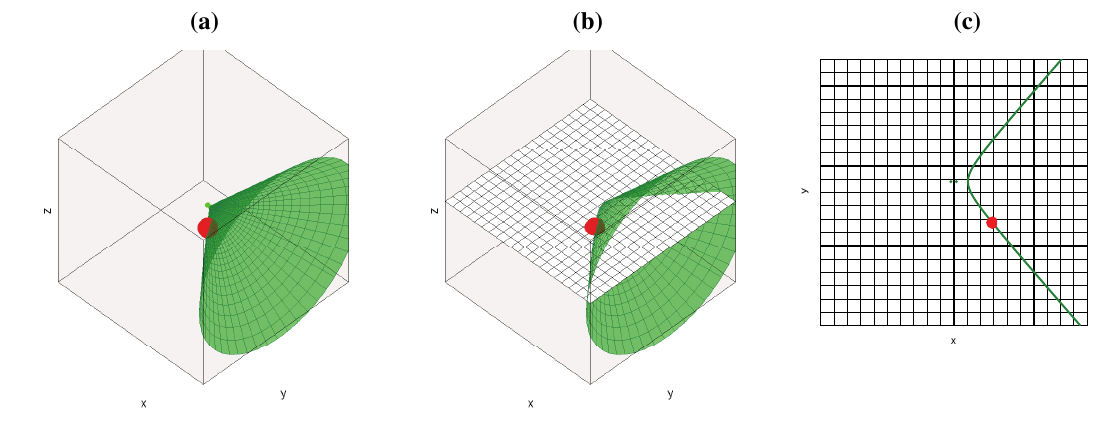
) generated for a microphone pair and a single Figure 1. Geometric places with equal srp ( q h acoustic source (a) 3D hyperboloid; (b) 3D hyperboloid cut by a plane; (c) Resulting 2D hyperbola (cutting hyperboloid by a